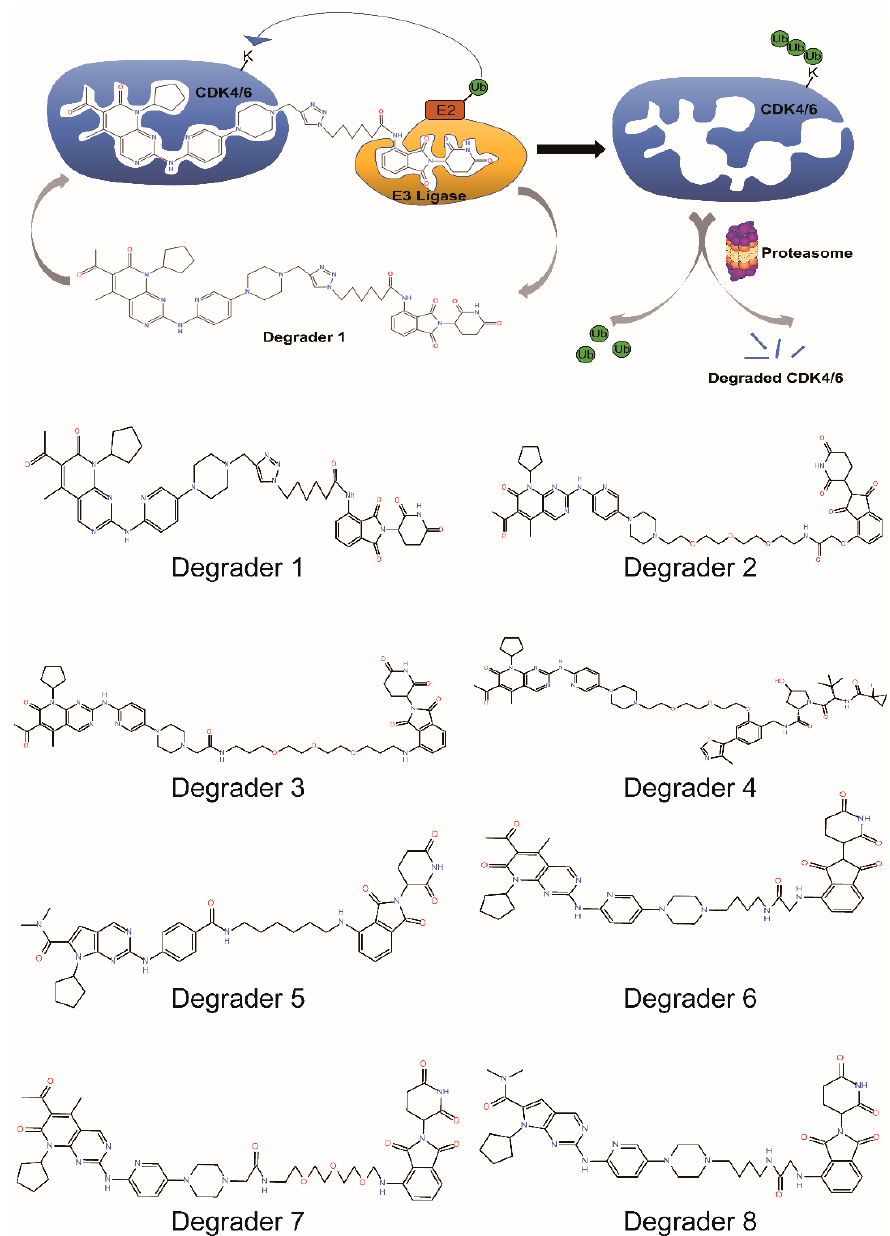
Figure 6. Mechanism of action of PROTACs in the degradation of CDK4/6 and chemical structures of selective CDK4/6 degraders.